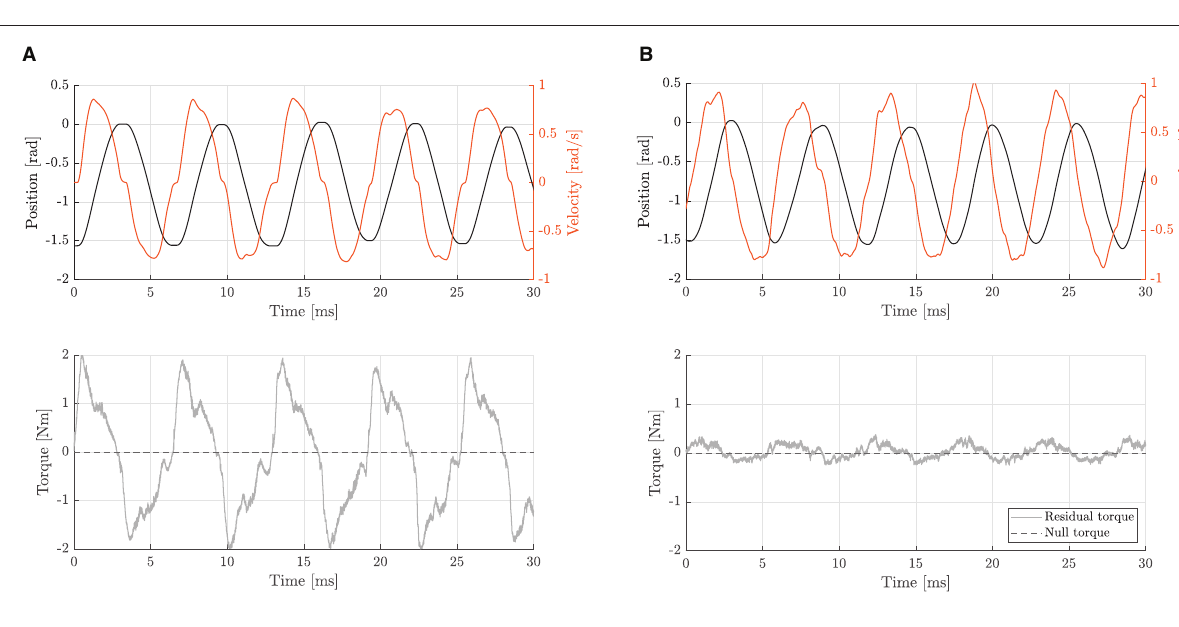
FIGURE 7 | Backdriving movements during free-motion at velocities ranging from -1.0 to 1.0 rad/s. The residual torque represents the difference between commanded (null) and measured torques. (A) With the open-loop null-torque control, no active disturbance rejection is enabled. Residual torques are up to 2.0 Nm. (B) With the closed-loop null-torque control, the inner torque loop is enabled. Residual torques range from about -0.3 to 0.3